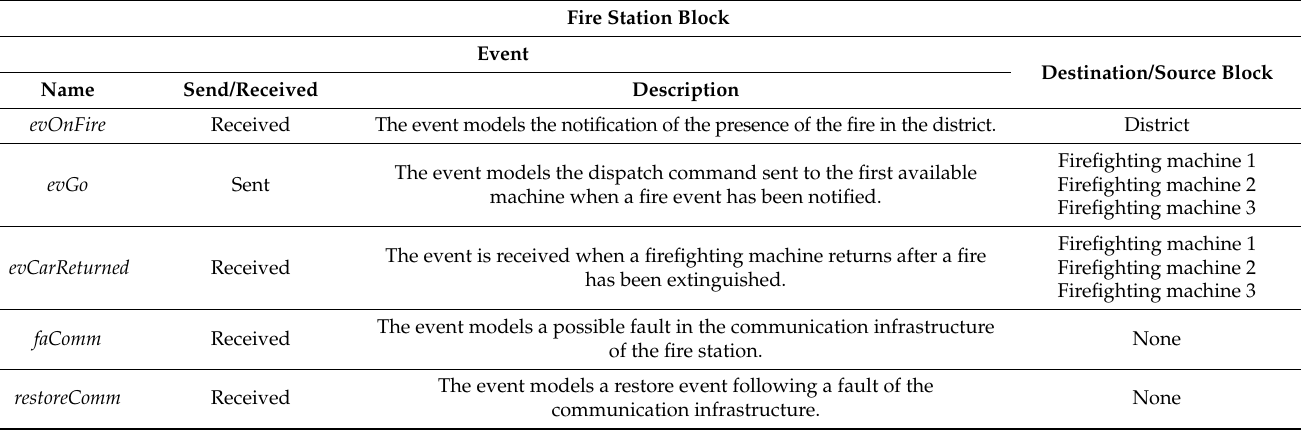
Table 2. Events list of the fire station CS block with event name, direction (send/received), description, and its destination/source